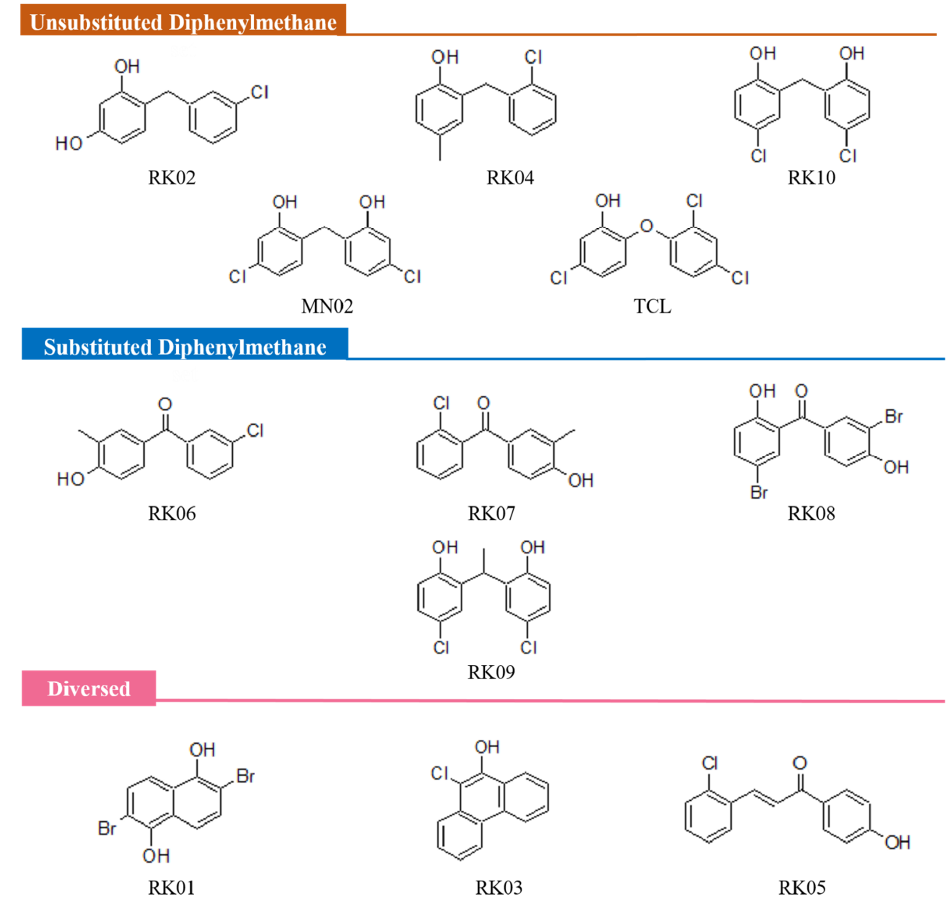
Figure 2. Structures of MN02, MN02 derivatives and triclosan. Based on their structures, the derivatives have been categorized into three sets: unsubstituted diphenylmethane, substituted Diphenylmethane and diverse.